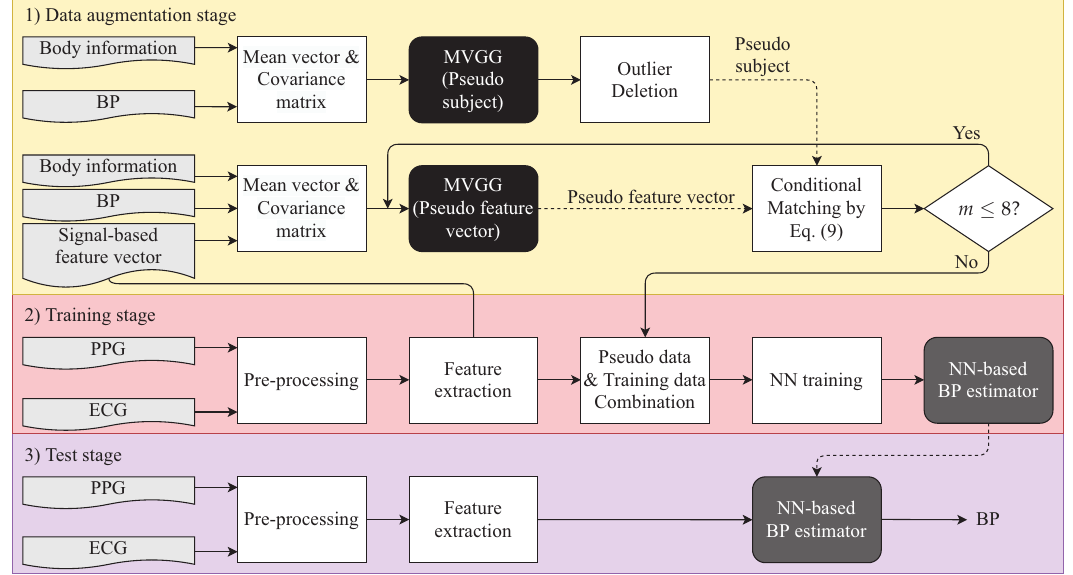
Figure 3. Block diagram of the NN-based BPE employing DA-MGD. Abbreviation; multivariate Gaussian distribution generateor